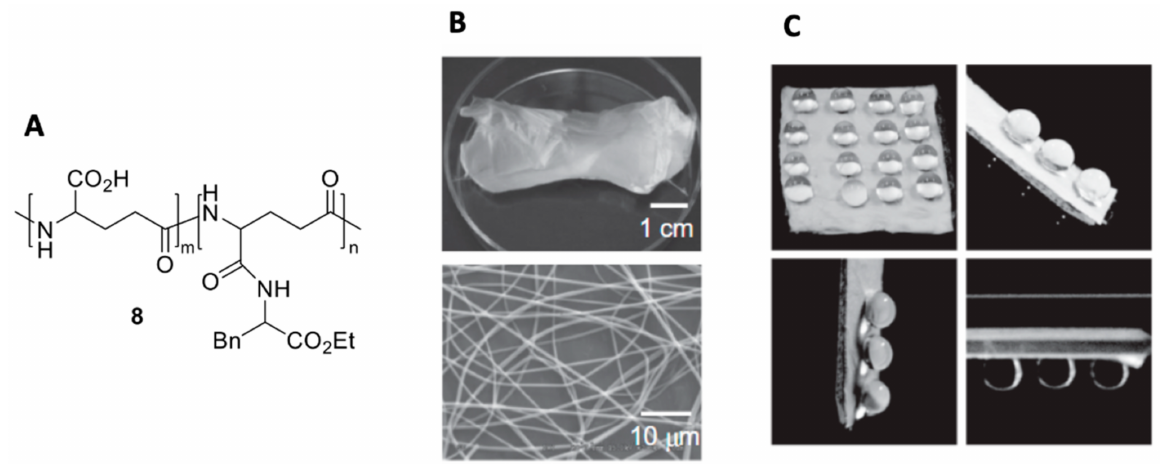
Figure 9. ( A ) Chemical formula of modified γ -PGA 8 . ( B ) Electrospun materials of compound 8 . ( C ) Strong adhesion of water droplets (“inversion test”). Reproduced from [21] with permission from John Wiley and